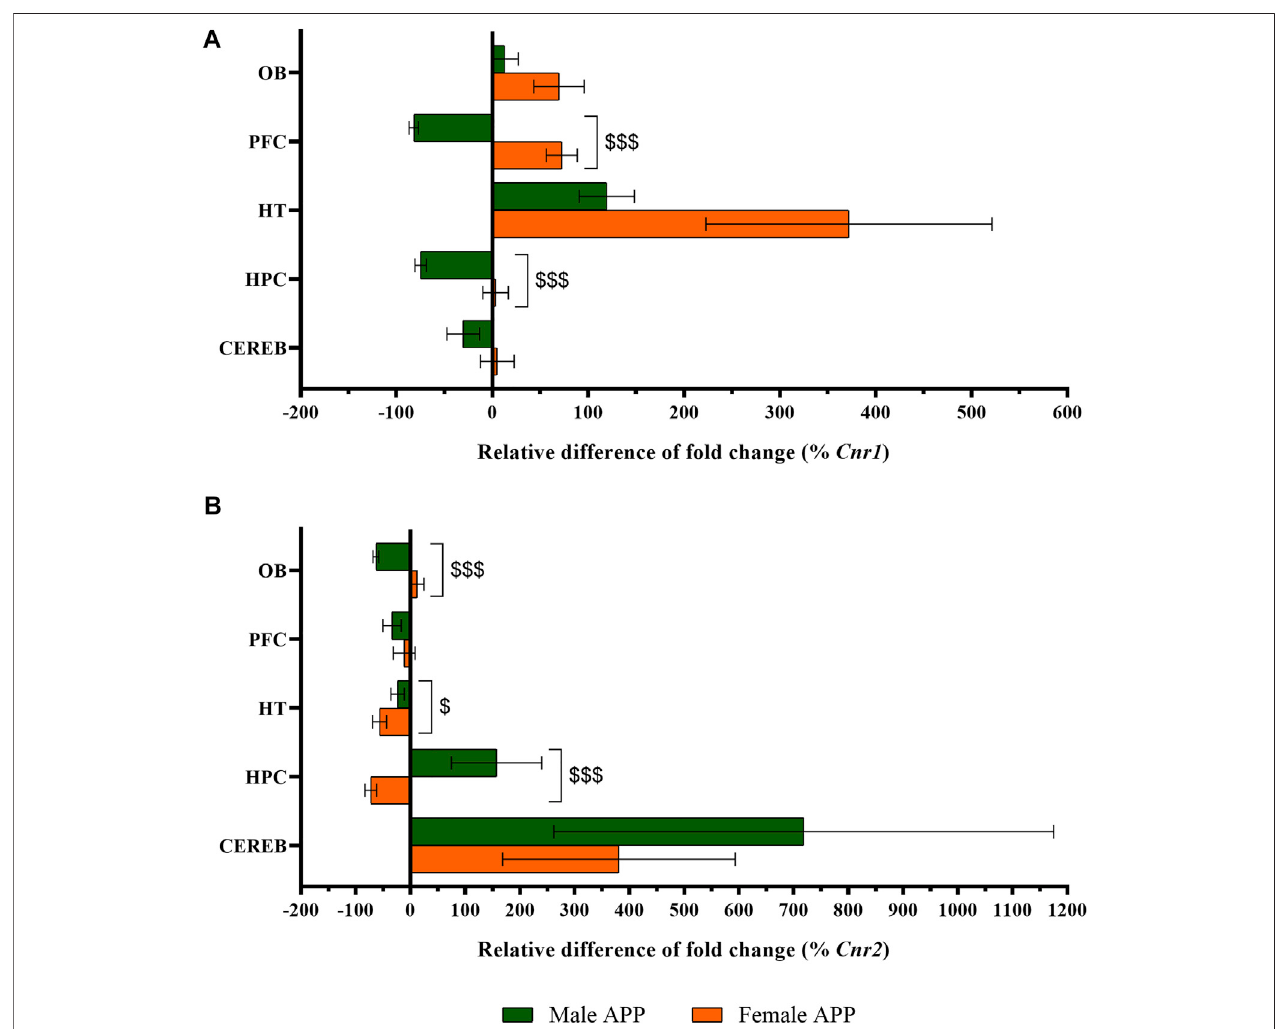
FIGURE5| Sex-differencesinCB1RandCB2RgeneexpressionbetweenWTandAPP/PS1mice(male n =9 – 10,female n =9 – 10).Expressionof (A) Cnr1 and (B) Cnr2 . The X axis represents the relative difference of the fold change in percentage. The Y axis shows the fi ve brain-regions analyzed: olfactory bulb (OB), prefrontal cortex(PFC),hypothalamus(HT),hippocampus(HPC),andcerebellum(CEREB).Valuesareexpressedasmean±SEM.$ p < 0.05,$$$ p < 0.001,vs.femaleAPPmice (sex effect); (Mann – Whitney